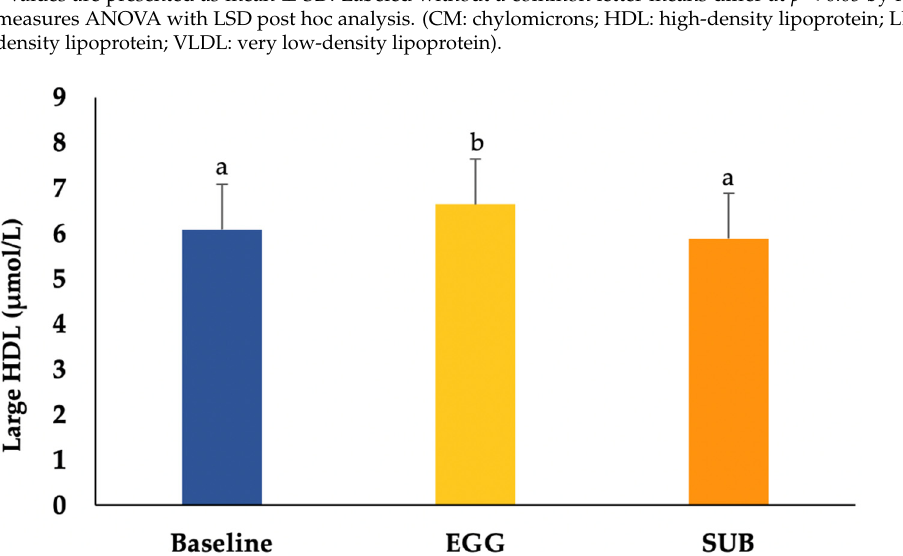
Figure 2. Concentrations of large HDL at baseline and after the intervention. Values are presented as mean ± SD. Values in the same row with different superscripts (a, b) are significantly different at a p < 0.01. The EGG breakfast resulted in higher concentrations of large HDL.